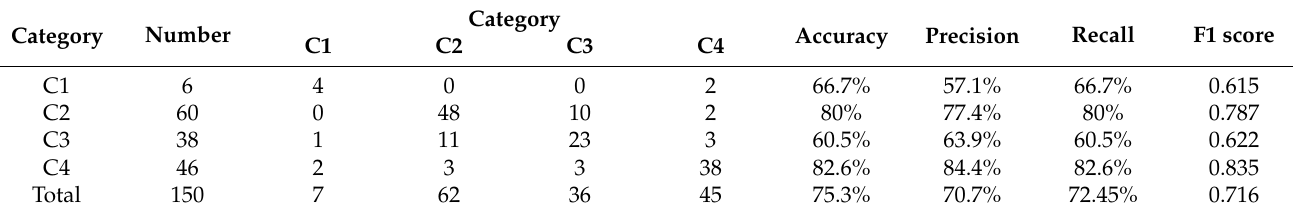
Table 5. Experimental results of CTD-DT using color texture features for DT classification.